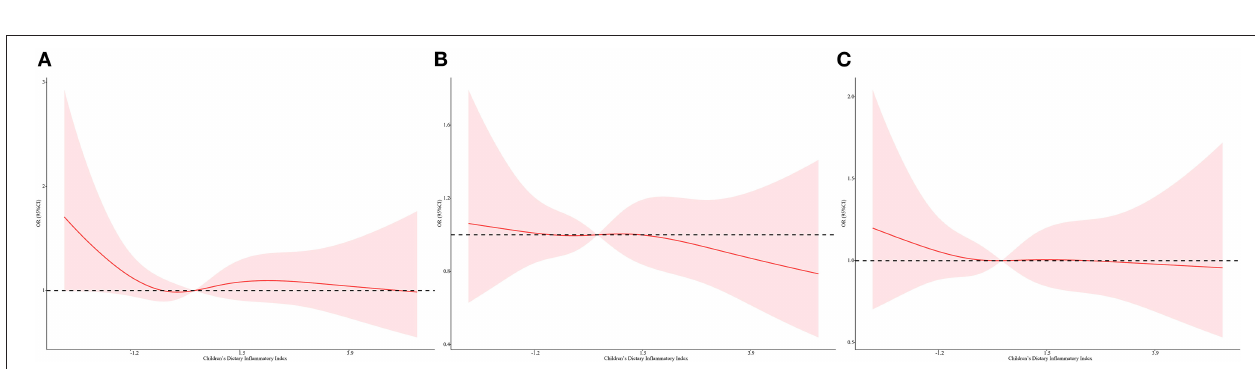
FIGURE 3 | Restricted cubic spline regressions of C-DII and the oxidative stress markers after adjusting for different covariates in model 3 for (A) serum bilirubin, (B) albumin, (C) serum iron. The red line and area represent the estimated OR values and their corresponding 95% CI. Model 3 adjusted for age, sex, race/ethnicity, cotinine exposure status, BMI, poverty-income ratio, body fat percentage and energy